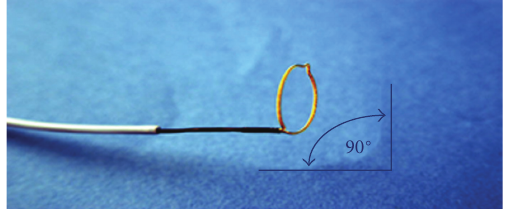
Figure 3: A 25mm Amplatz GOOSE NECK Snare.